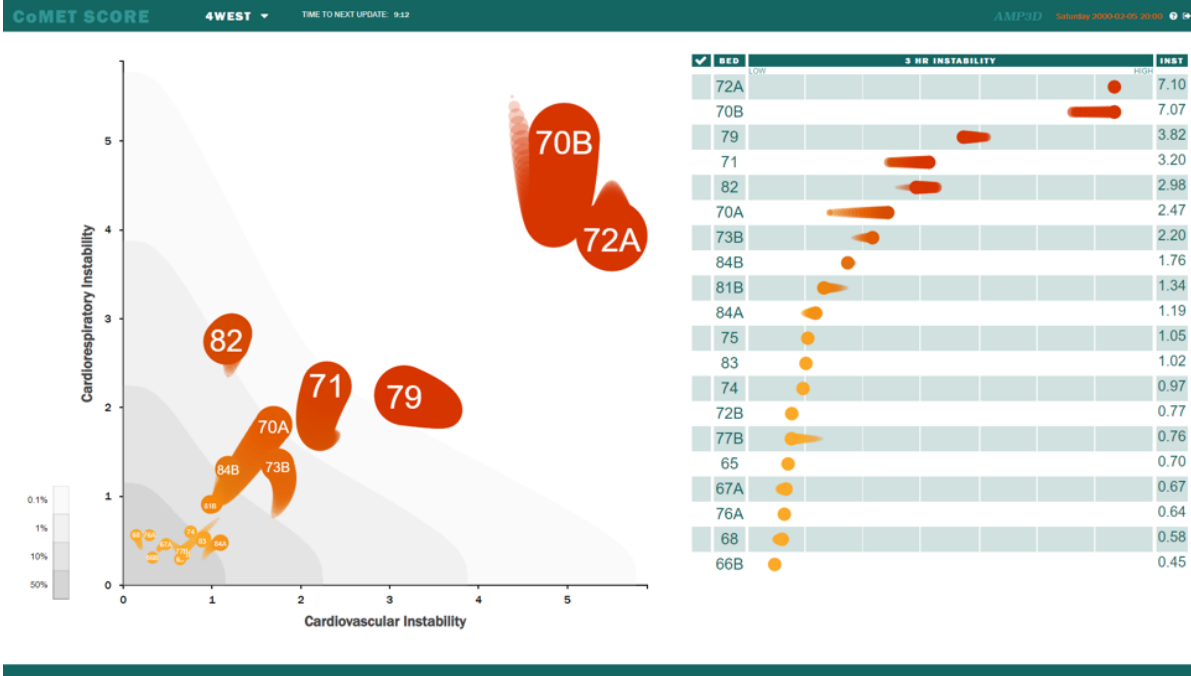
Figure 1. CoMET artificial intelligence–based visual risk analytic. CoMET: Continuous Monitoring of Event